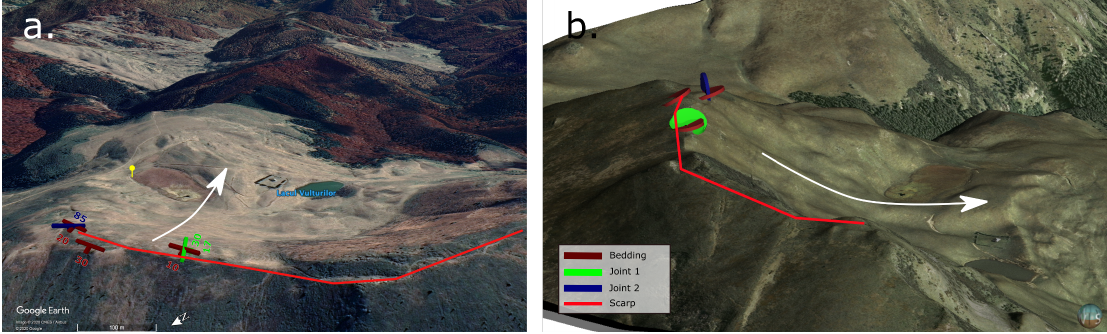
Figure 9. ( a ) Google Earth R (cid:13) views of the Eagle’s Lake rockslide with the strike-dip symbols of the measurement. The yellow icon has as coordinates of latitude 45 ◦ 30 (cid:48) 43.90 (cid:48)(cid:48) N and longitude 26 ◦ 8 (cid:48) 6.76 (cid:48)(cid:48) E. ( b ) 3D geomodel of the Eagle’s Lake rockslide with a view towards the NE, the disks mark the local strike and dip orientation.